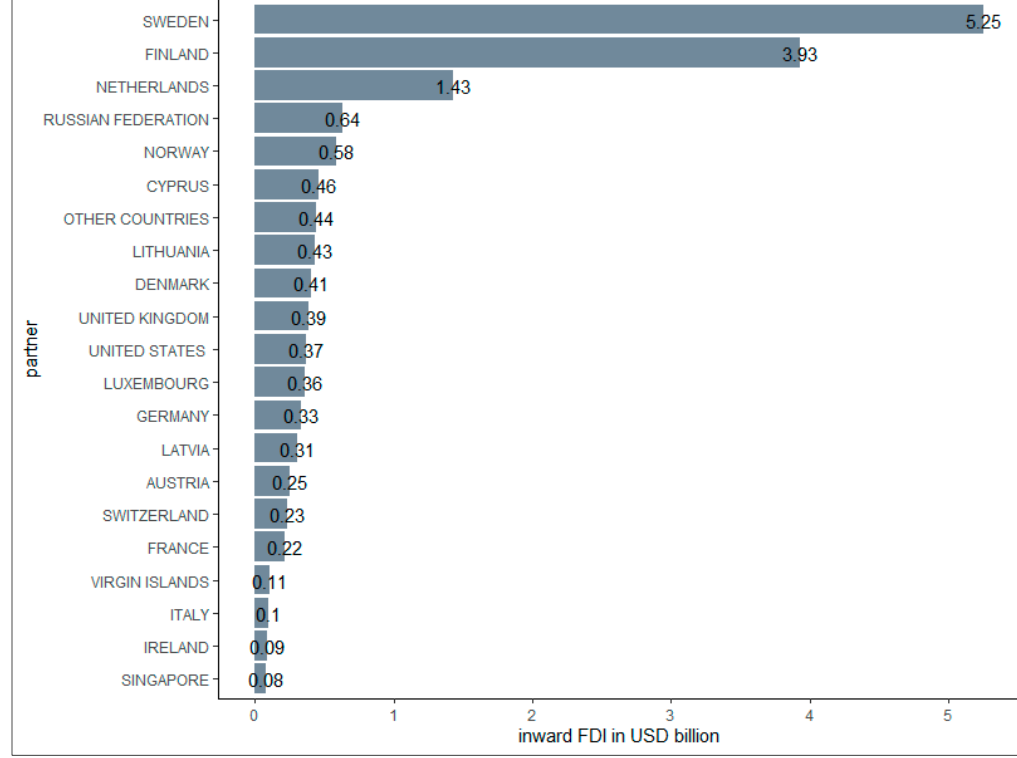
Figure A2. Average inward FDI stocks by partners in Estonia across 2004–2017.